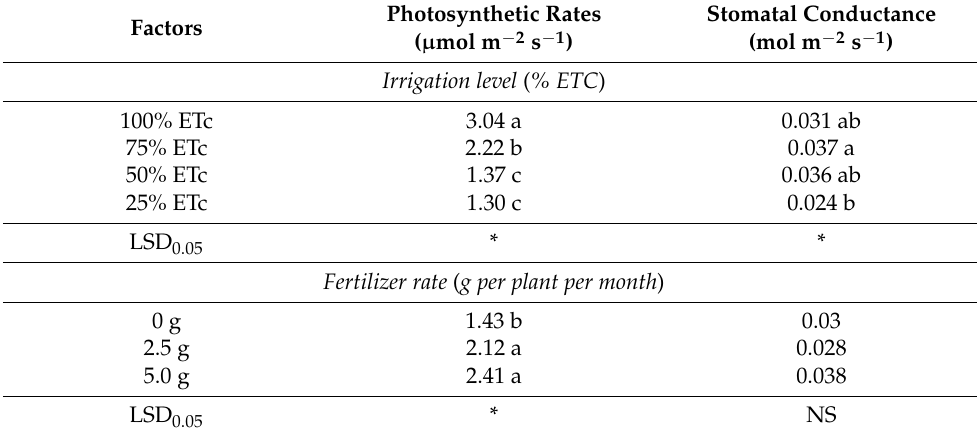
Table 5. Photosynthetic rates ( µ mol m − 2 s − 1 ) and stomatal conductance (mol m − 2 s − 1 ) of Hippeastrum ‘Red Lion’ grown under different irrigation levels and fertilization rates 180 days after